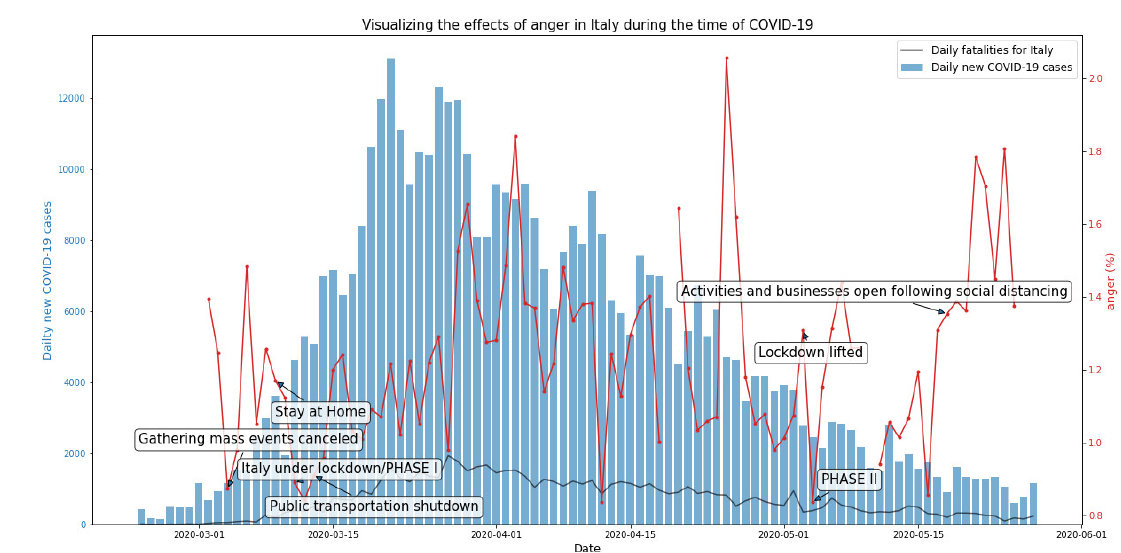
Figure 3. Anger-related tweets in Italy during the first wave of the COVID-19 pandemic.